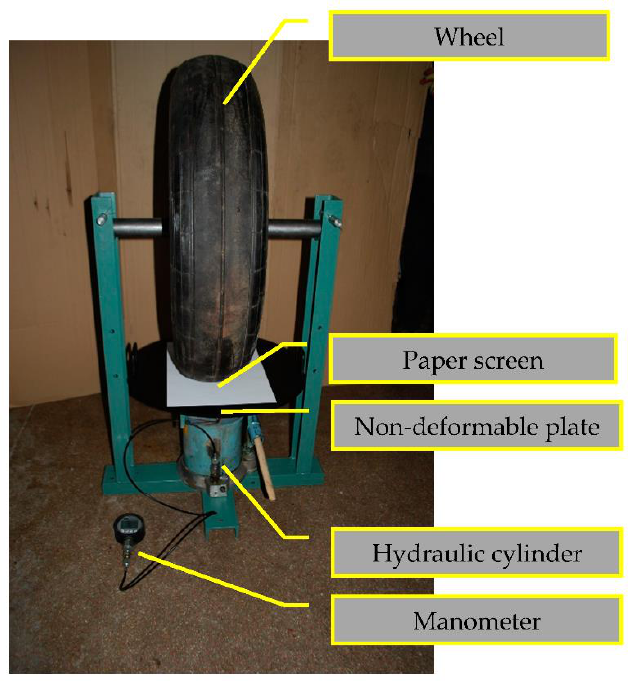
Figure 6. View of the test stand.